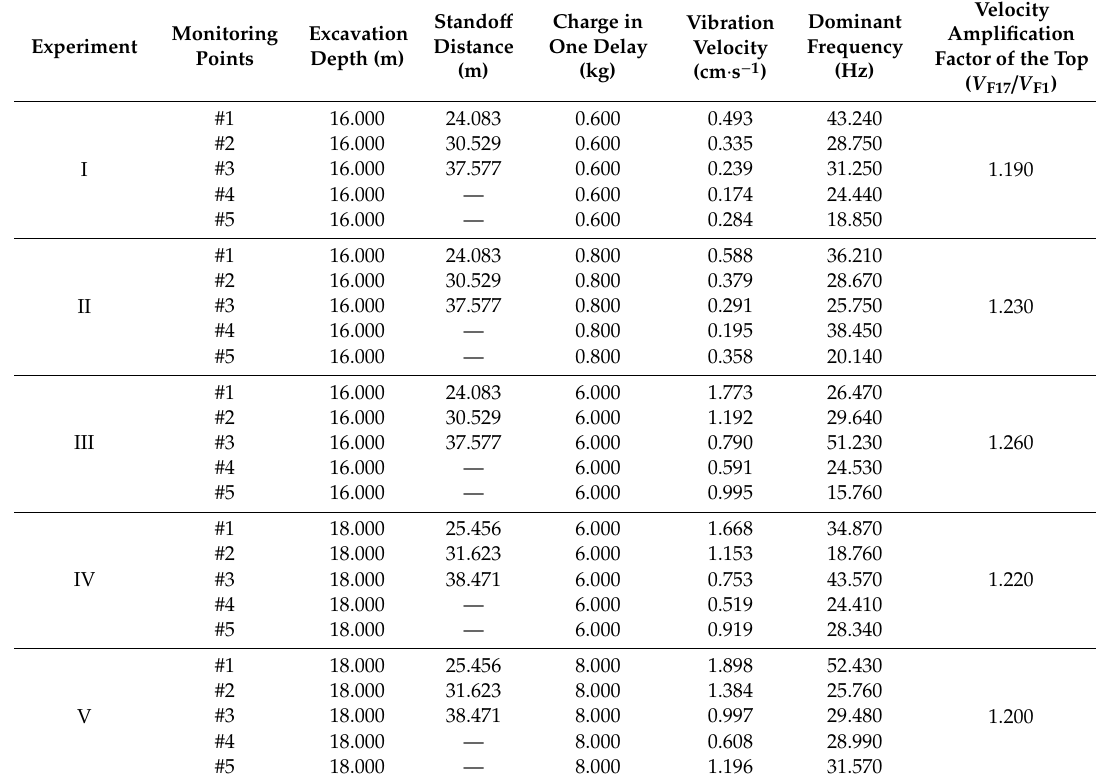
Table 1. Experiment results.